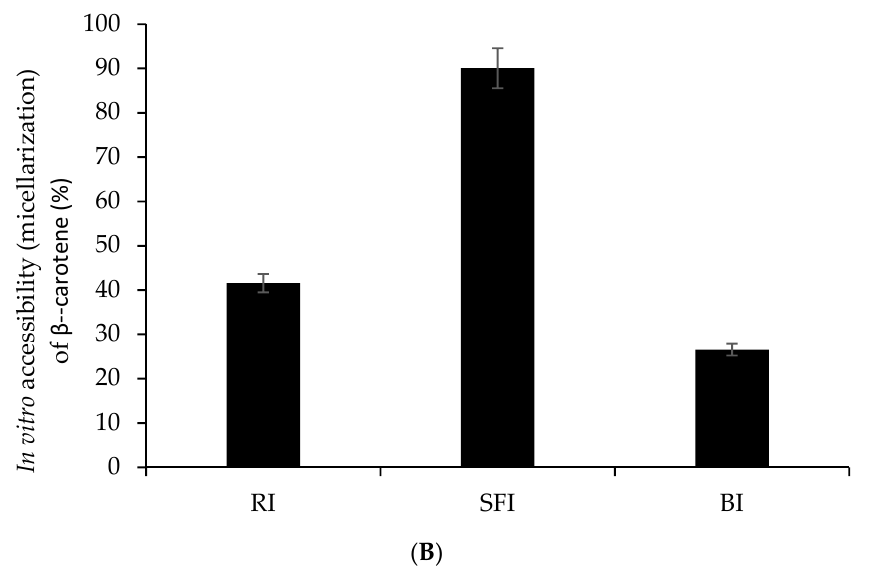
Figure 3. ( A ) Impact of stir-frying or boiling on the released β -carotene content from African pumpkin leaves during simulated gastrointestinal digestion compared to the whole raw leaves. RU—undigested raw leaf; RI—Intestinal digesta of raw leaves; SFU—undigested stir-fried leaves; RI—Intestinal digesta of stir-fried leaves; BU—undigested boiled leaves; BI—intestinal digesta of boiled leaves. Each bar represents the mean value of three samples per digestive stage or raw leaves; the standard deviations are included in the bars. Different alphabet letters in the same bar for African pumpkin leaves indicate significant differences at ( p < 0.05). ( B ) In vitro bioaccessibility of β -carotene from stir-fried or boiled African pumpkin leaves compared to the whole raw leaves. RI—Intestinal digesta of raw leaves; SFI—Intestinal digesta of stir-fried leaves; BI—Intestinal digesta of boiled leaves. Each bar represents the mean value of three samples per digestive stage or raw leaves. Standard deviations are included in the bars. Different alphabet letters in the same bar for African pumpkin.